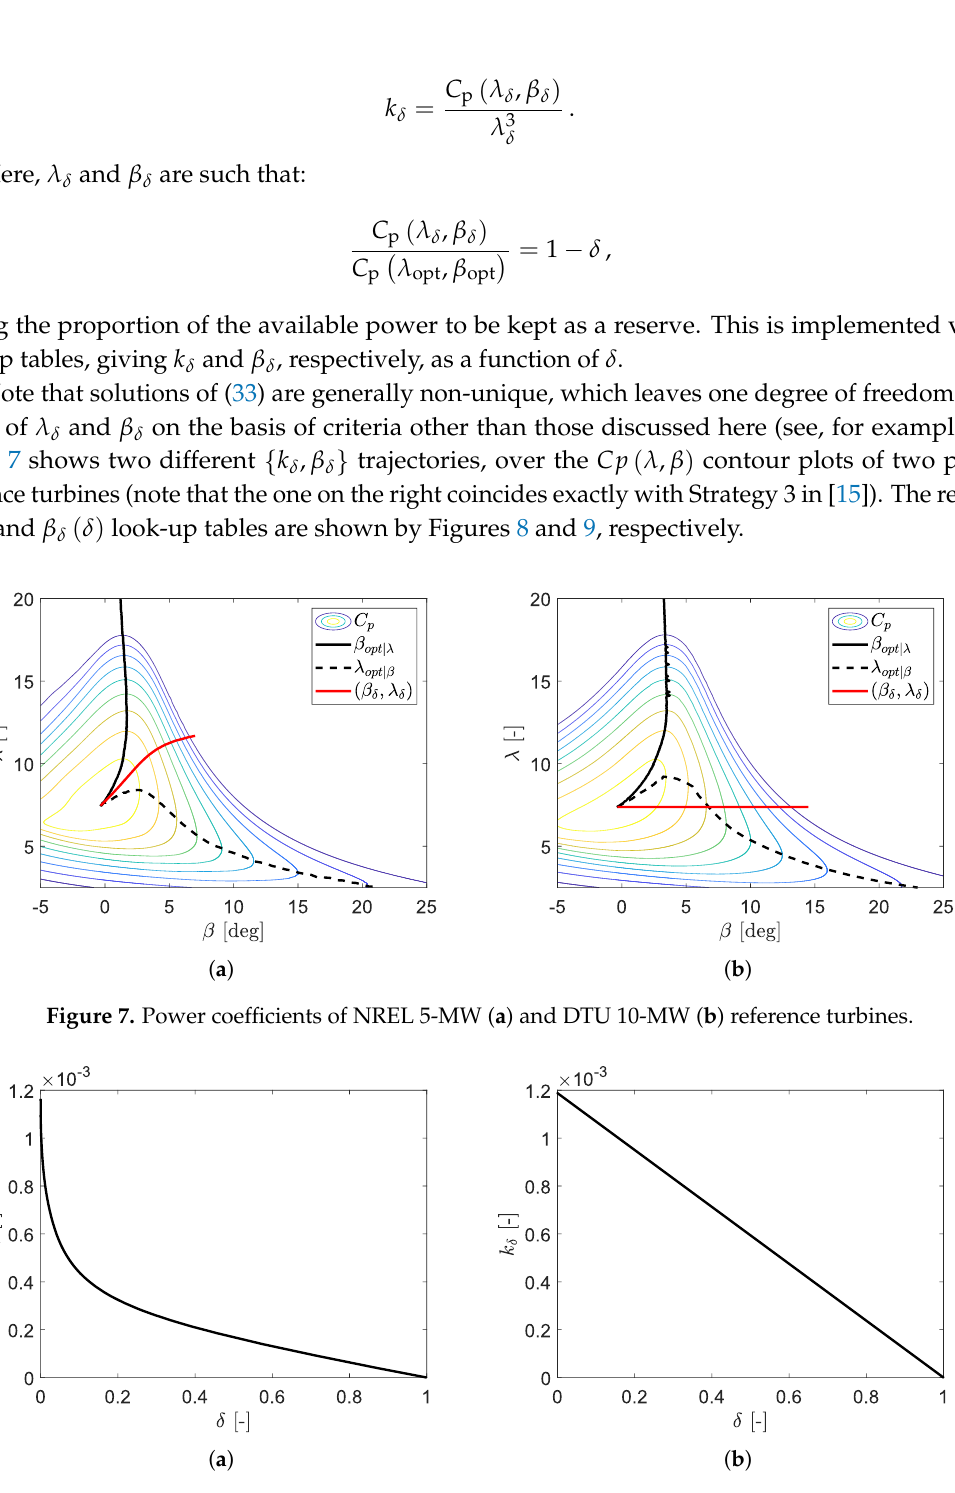
Figure 8. k δ ( δ ) tables for NREL 5-MW ( a ) and DTU 10-MW ( b ) reference